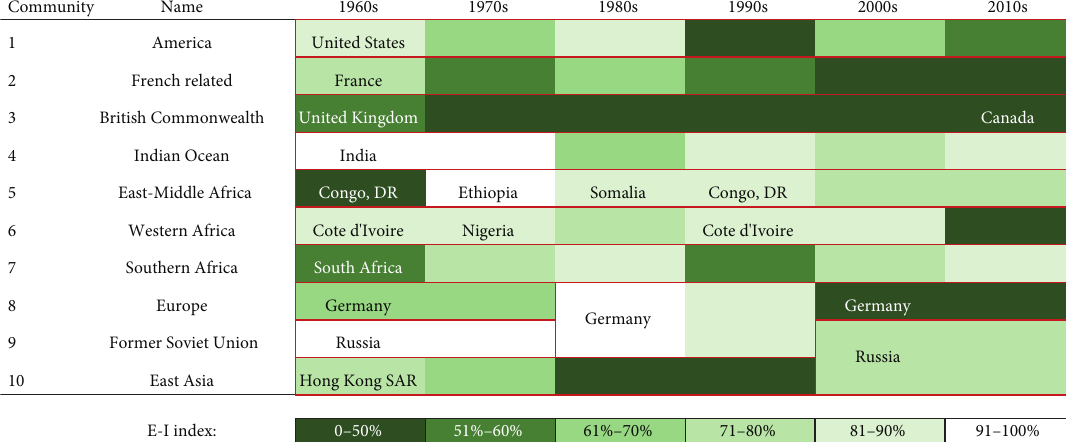
Figure 9: E-I index ( degree ) for each community from the 1960s to the 2010s. The countries/regions having the largest degrees in the communities are listed in the